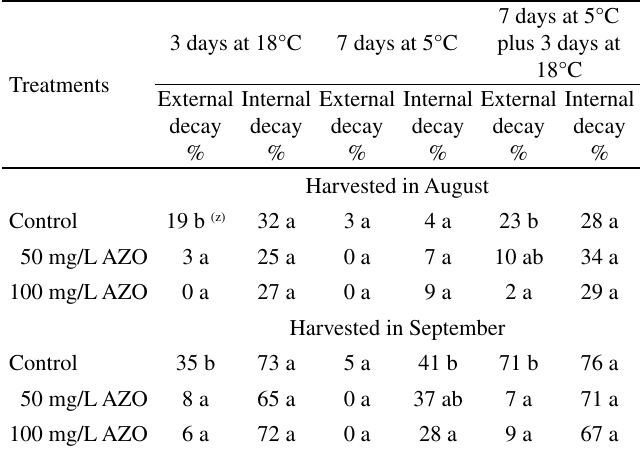
(z) For each storage period and harvesting time values in columns fol- lowed by different letters are significantly different at P≤0.05 accord- ing to Fisher’s test of the least significant difference.